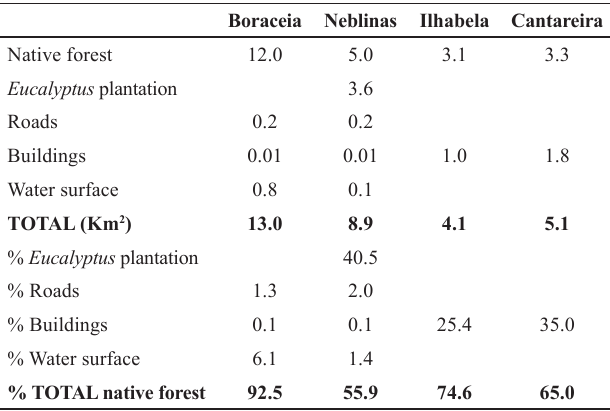
Table 4 . Measures (Km 2 and percentage) of the land-uses on the four study